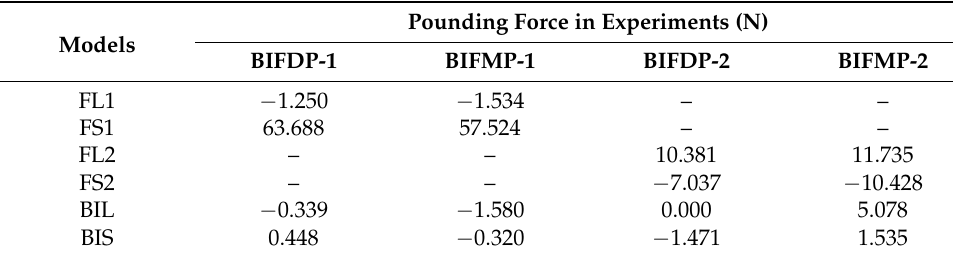
Table 10. The pounding effect between flexible base-isolated models.